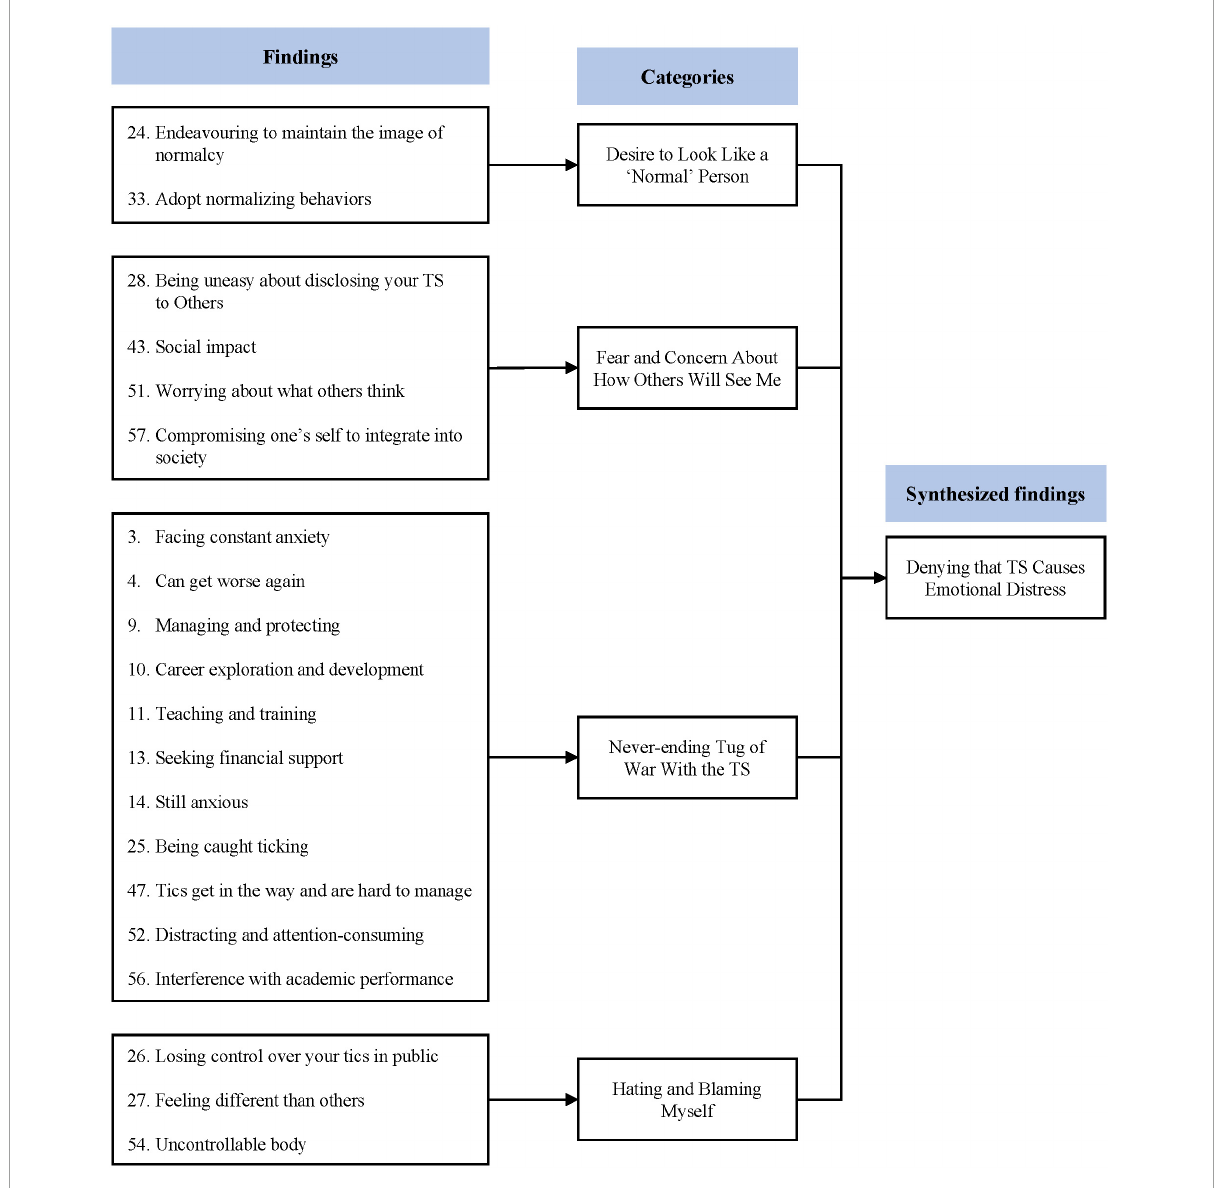
FIGURE3 Synthesized finding 2: Denying that TS causes emotional distress.